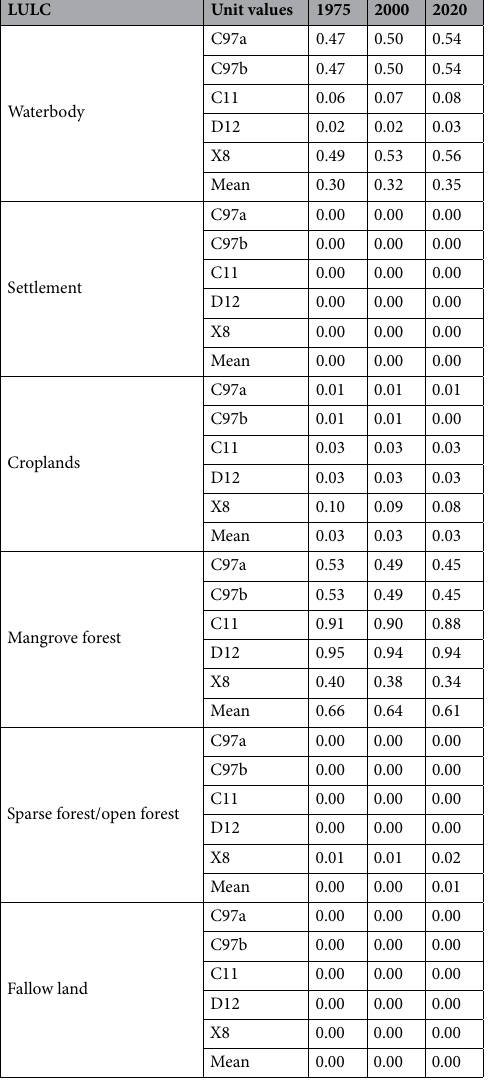
Table 6. Coefficient of sensitivity (CS) of ESVs respected with LULC changes for the reference years using five various unit